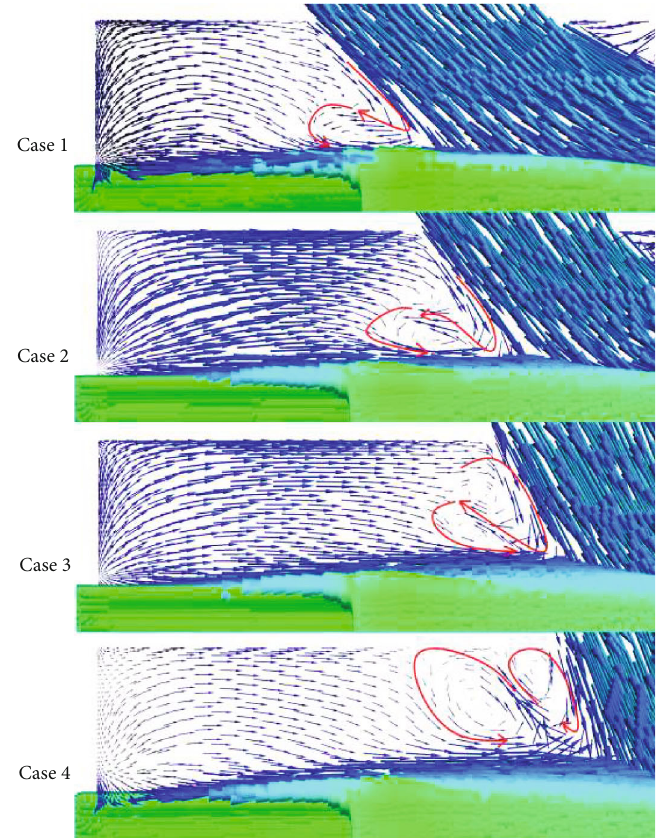
Figure 10: The velocity vector in the front side of the air inlet exits.